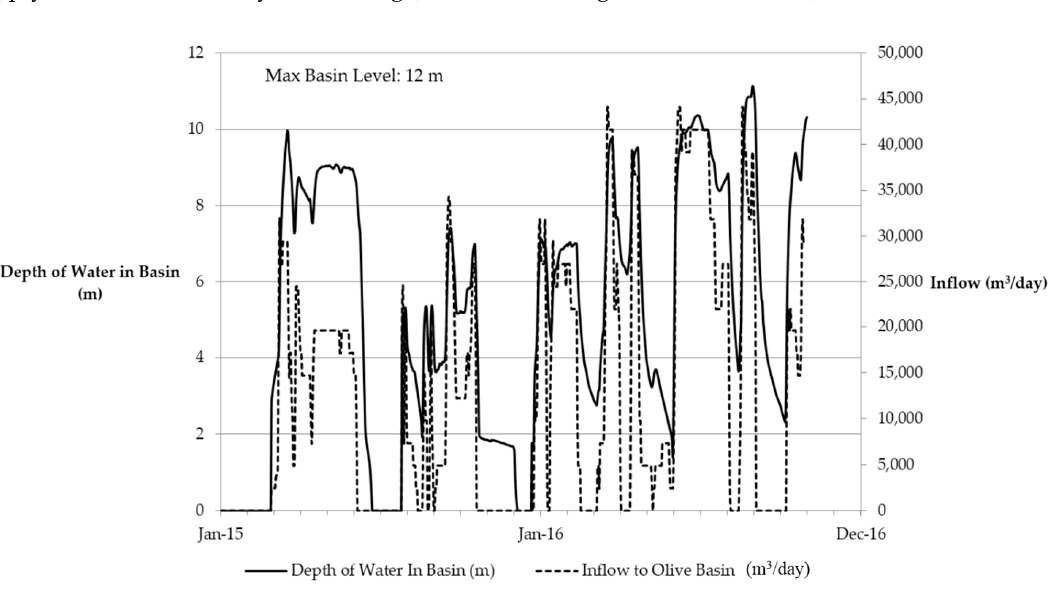
Figure 4. Olive Basin Percolation Rate with Water from Unfiltered Santa Ana River (SAR) and Riverbed Filtration System. Water quality testing shows that the RFS is very effective in removing suspended solids. Samples collected to date indicate the RFS removes from 70% to 99% of the suspended solids in the source water with an average removal of 97%. Figure 5 shows the range of source water and RFS product water TSS concentrations from December 2014 to October 2016. Table 4 summarizes changes in selected water quality constituents, including TSS. ‐ 5,000